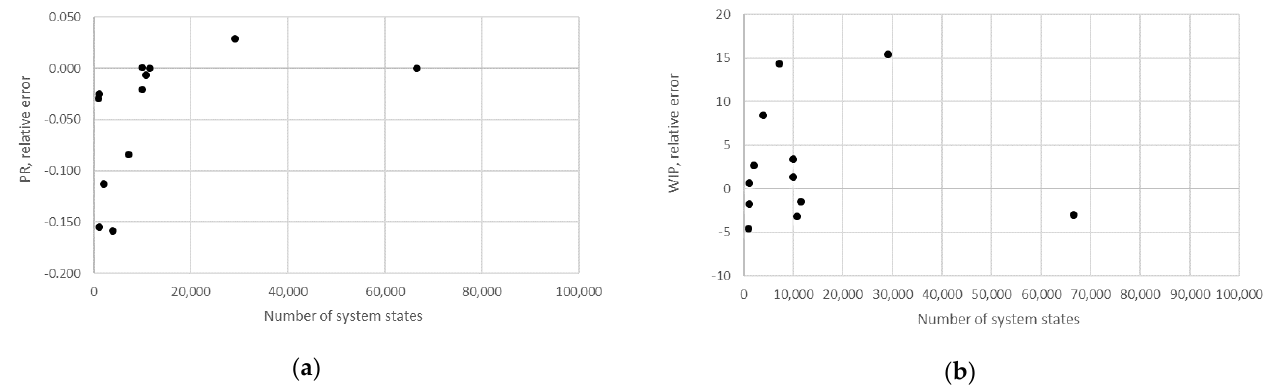
Figure 25. M = 6, relative error obtained using the numerical method—( a ) PR and ( b ) WIP.